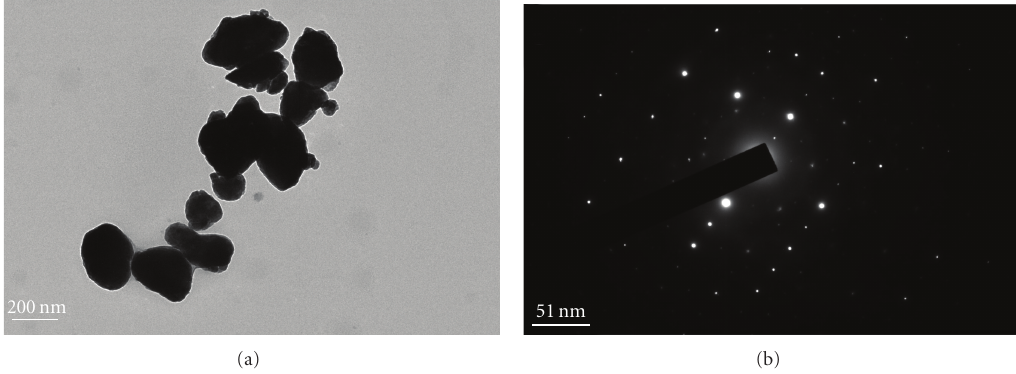
Figure 1: TEM image of Fe 2 BiSbO 7 (a) and the selected area electron di ff raction pattern of Fe 2 BiSbO 7 (b).